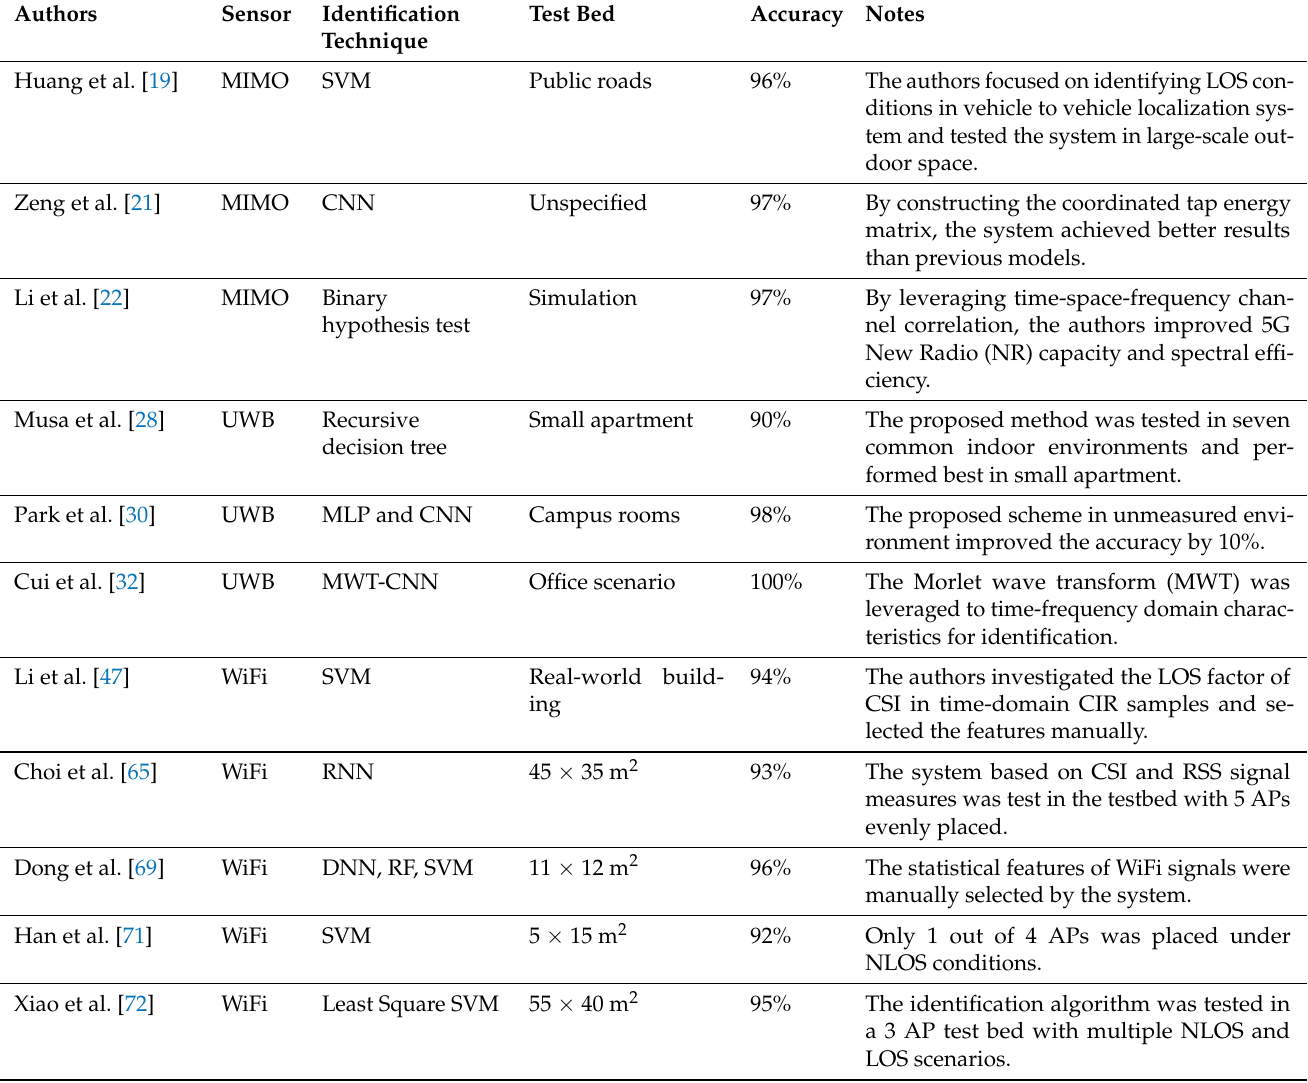
Table 1. Comparison of the performance of notable work in LOS